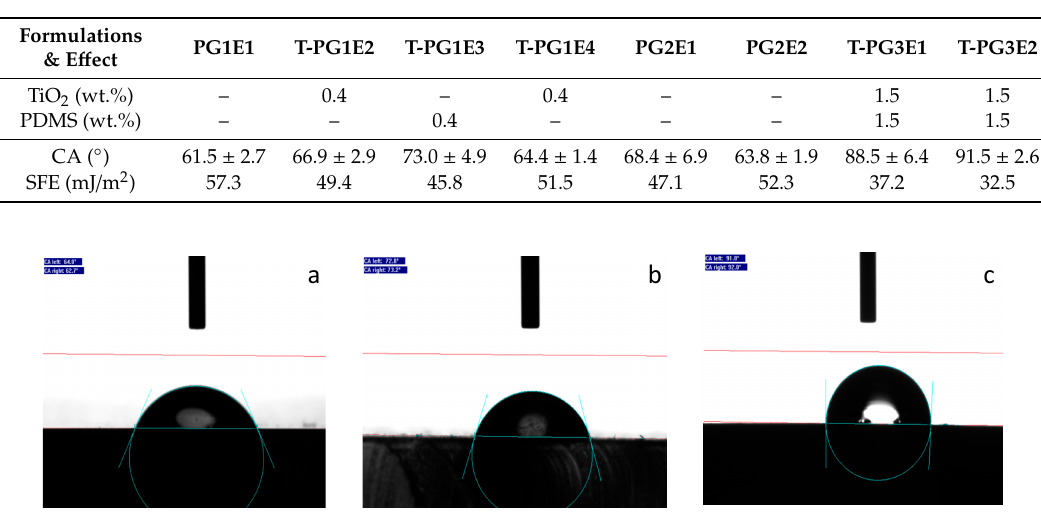
Table 2. Values (mean ± standard deviation) of contact angle (CA) and surface energy (SFE).